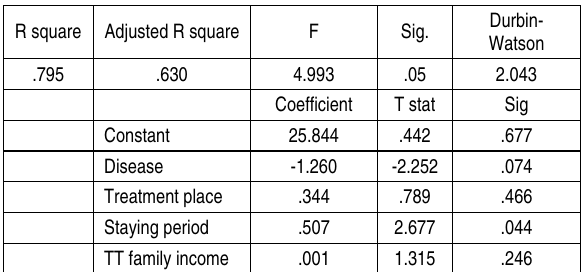
Table 2. Regression equation 2, dependent variable: